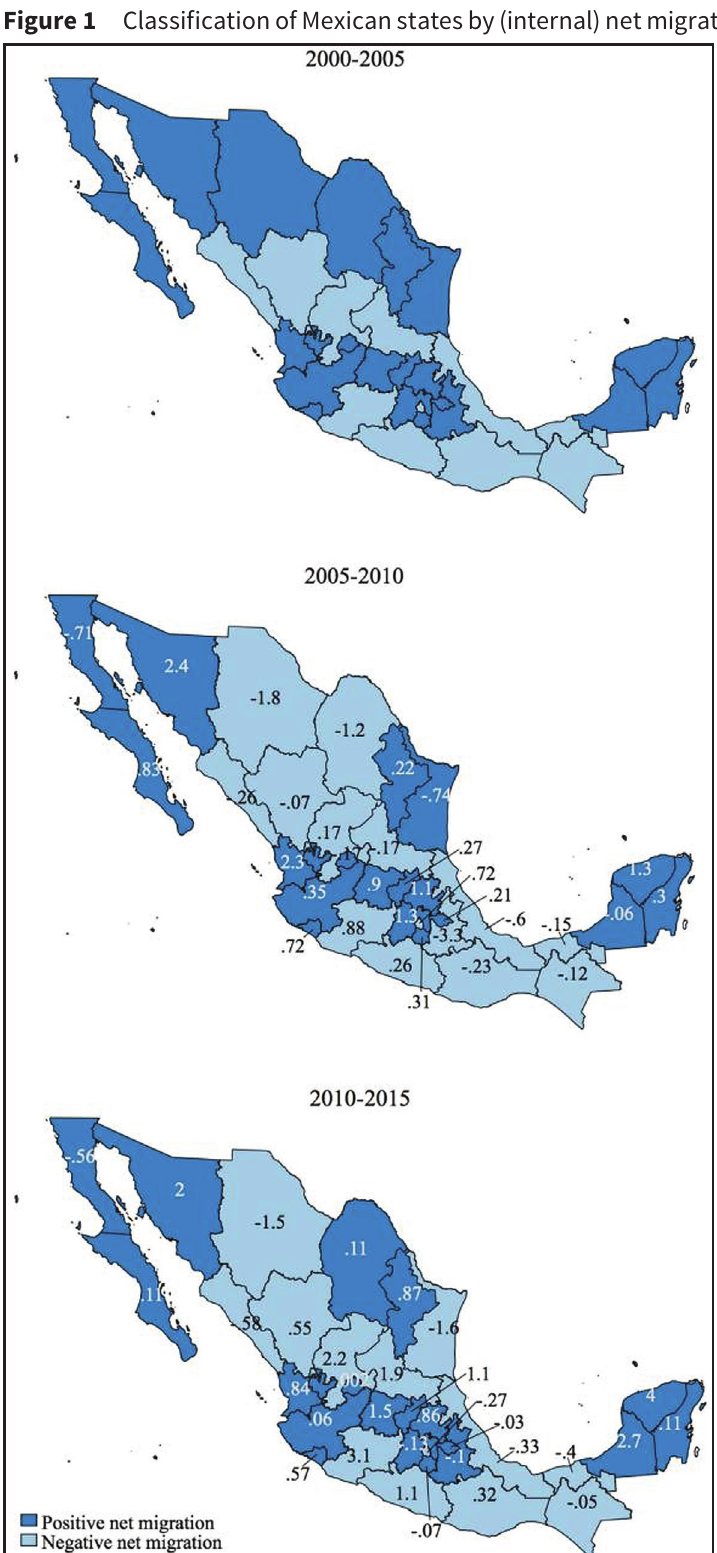
Classification of Mexican states by (internal) net migration condition and